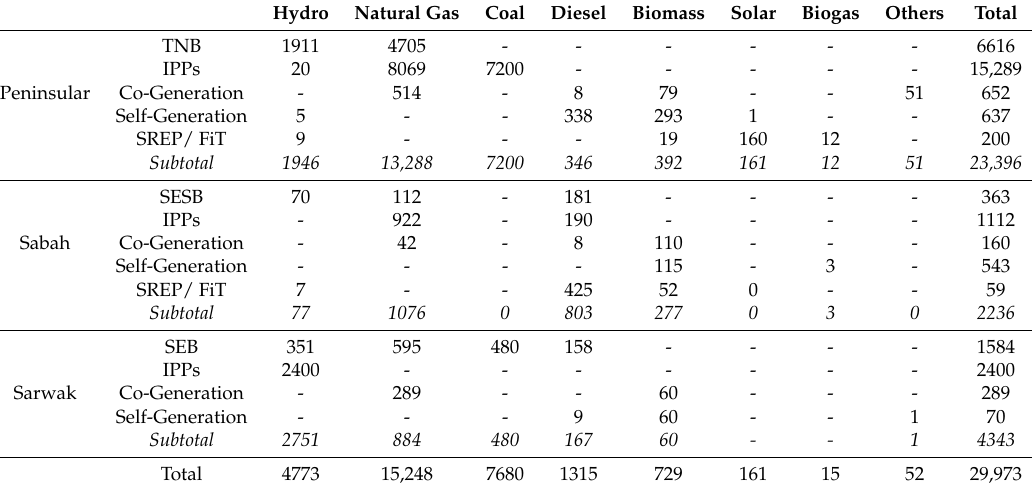
Table 1. Summary of the installed capacity (MW) in Malaysia until 2014